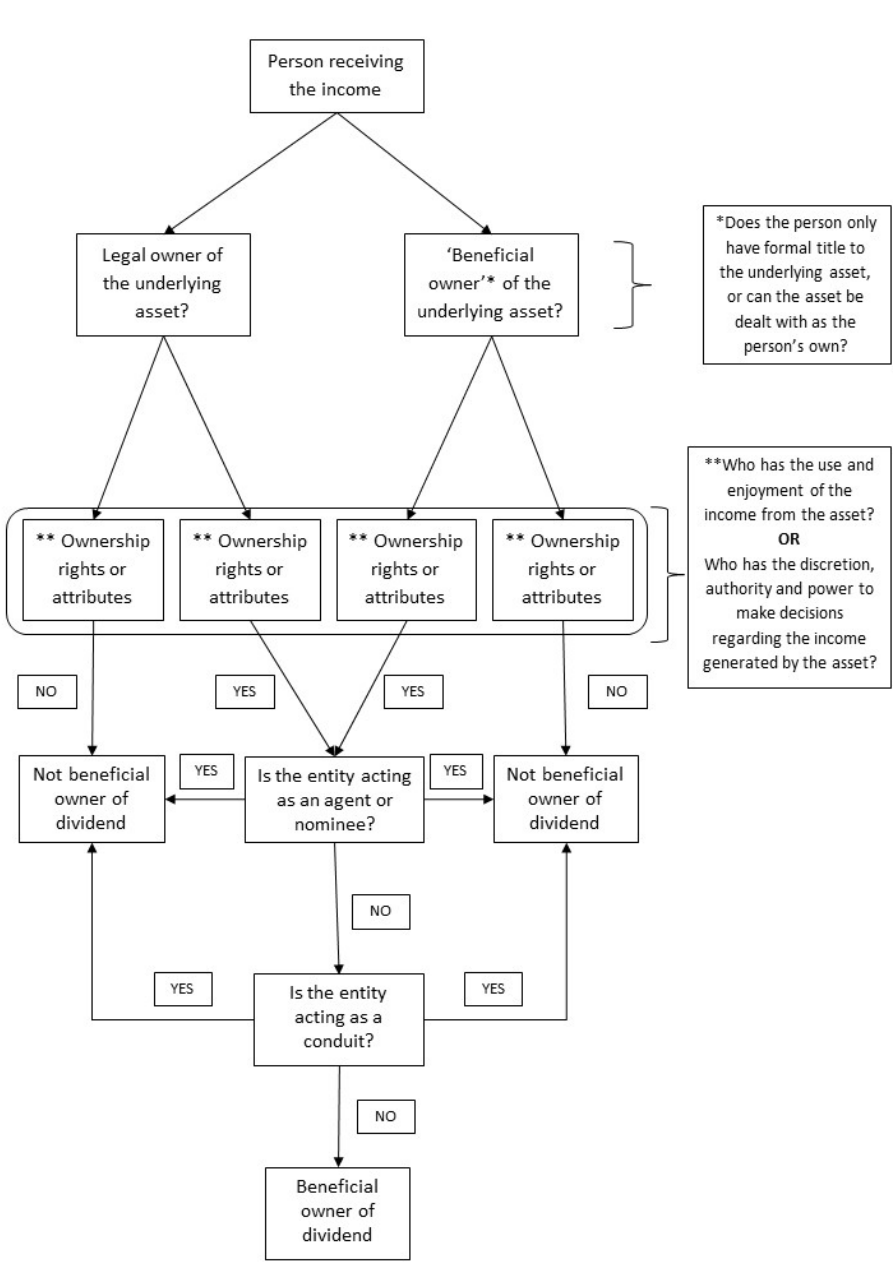
FIGURE 4: The factors in determining the beneficial owner (combined from FIGURE 3)